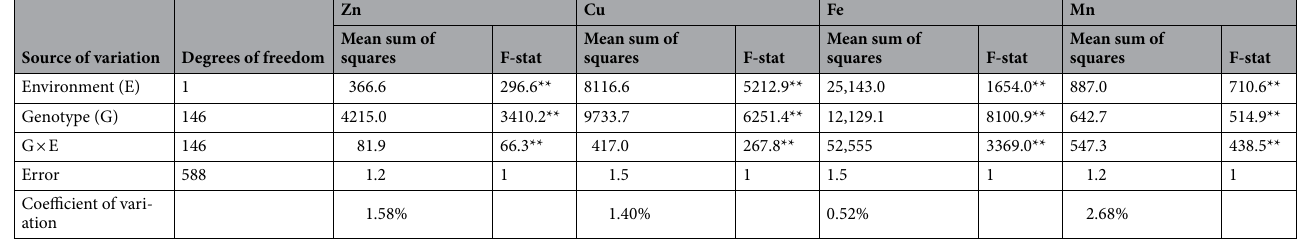
Table 2. Combined Analysis of Variance (ANOVA) conducted for chickpea seed micronutrient (Zn, Cu, Fe and Mn) concentrations. The table shows the variation contributed by different sources/factors for seed micronutrient data collected over different years. **Denotes that values are statistically significant at p-value of less than 0.01.